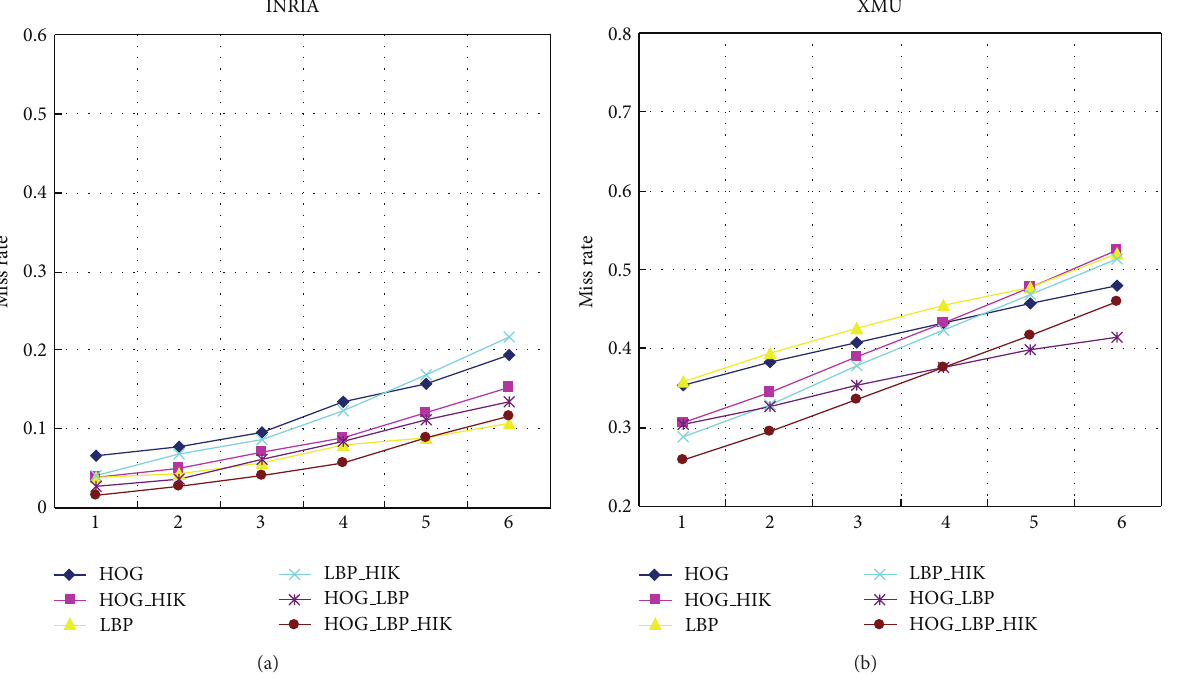
Figure 12: Comparison of missing rates using various combinations of features (single features or feature fusion) when random blocks were added to test-cropped